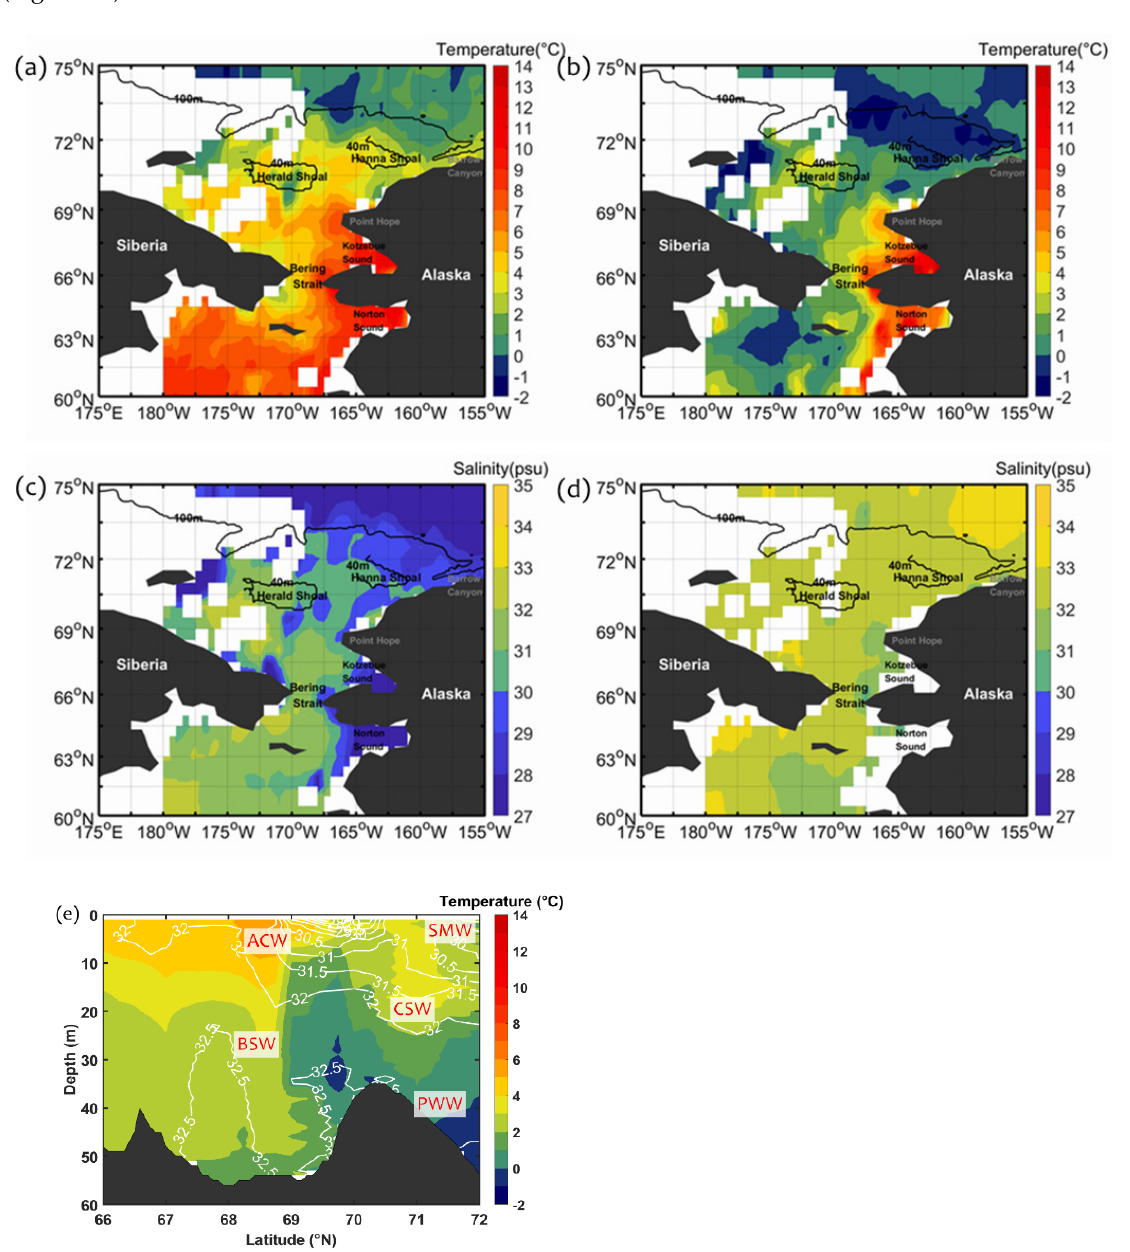
Figure 3. Long-term mean ( a ) surface and ( b ) bottom temperature, ( c ) surface and ( d ) bottom salinity according to available data of the summer seasons from 1974 to 2017; ( e ) vertical section of temperature (shaded) and salinity (white contour) along 169 ◦ W. The solid black contours in panels a–d represent the 100 m and 40 m